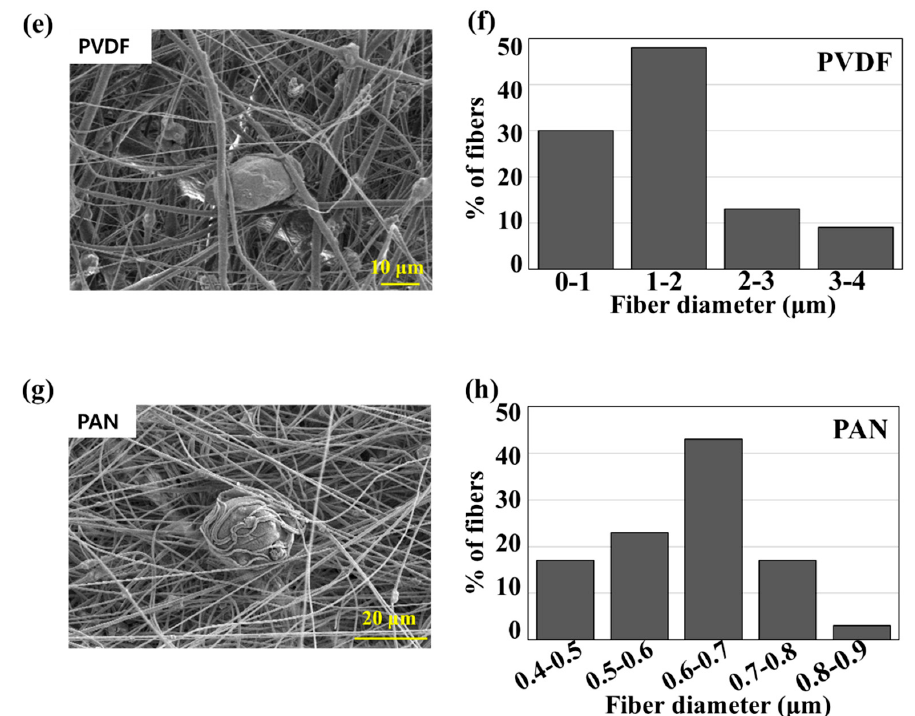
Figure 3. ML and ML-incorporated electrospun composites. ( a ) SEM of ML particles; ( b ) size distribution of ML particles; ( c ) fluorescence image of ML/PVDF fibers; ( d ) fluorescence image of ML/ polyacrylonitrile (PAN) fibers; ( e ) SEM image of ML/PVDF fibers; ( f ) diameter distribution of ML/PVDF fibers; ( g ) SEM image of ML/PAN fibers; ( h ) diameter distribution of ML/PAN fibers. *Note. A total number of fifty ML particles were measured for size distribution; a total number of thirty fibers were measured for the diameter distribution of ML composites.